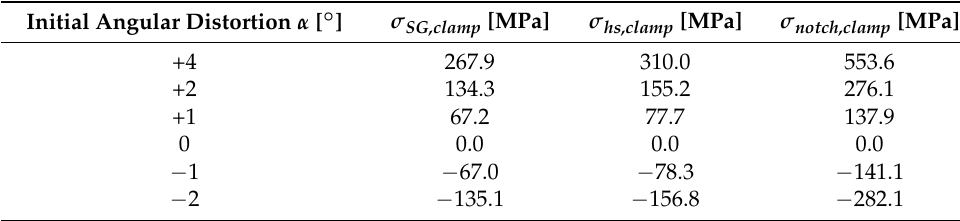
Table 4. Numerically computed stresses due to clamping.